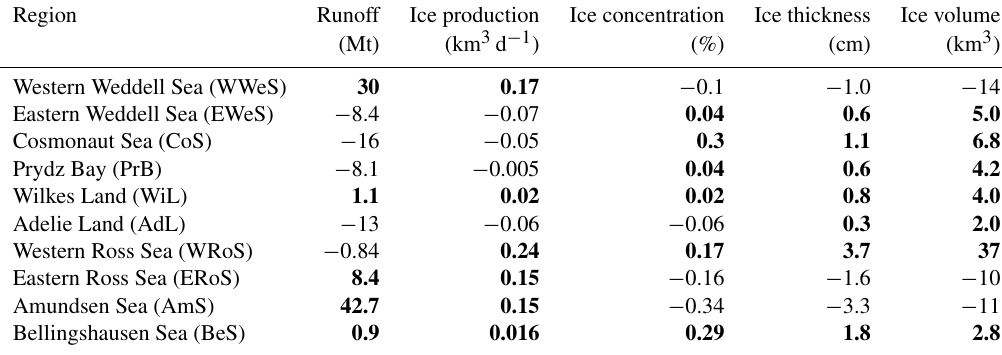
Table 2. Differences between S2 and CTR computed as mean over the selected regions for April–September 2004–2013 period. Positive numbers are printed in bold